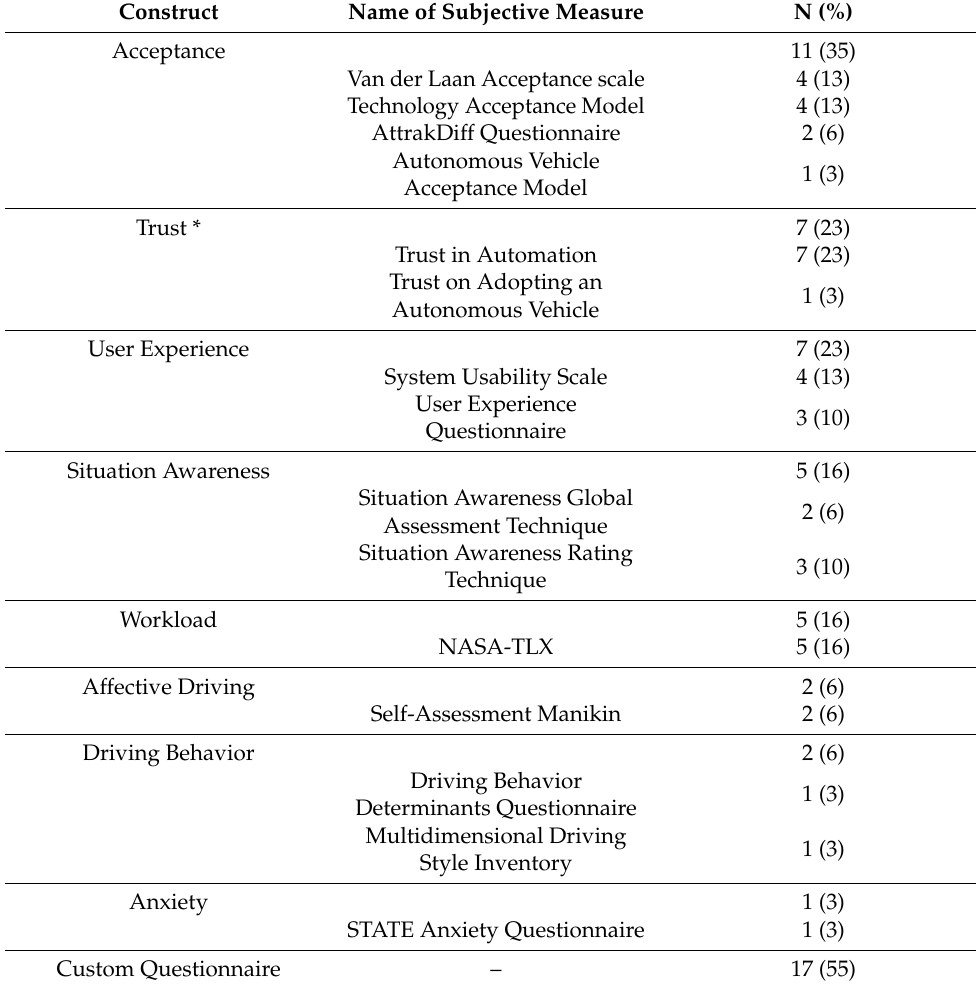
Table 2. Summary of administered subjective